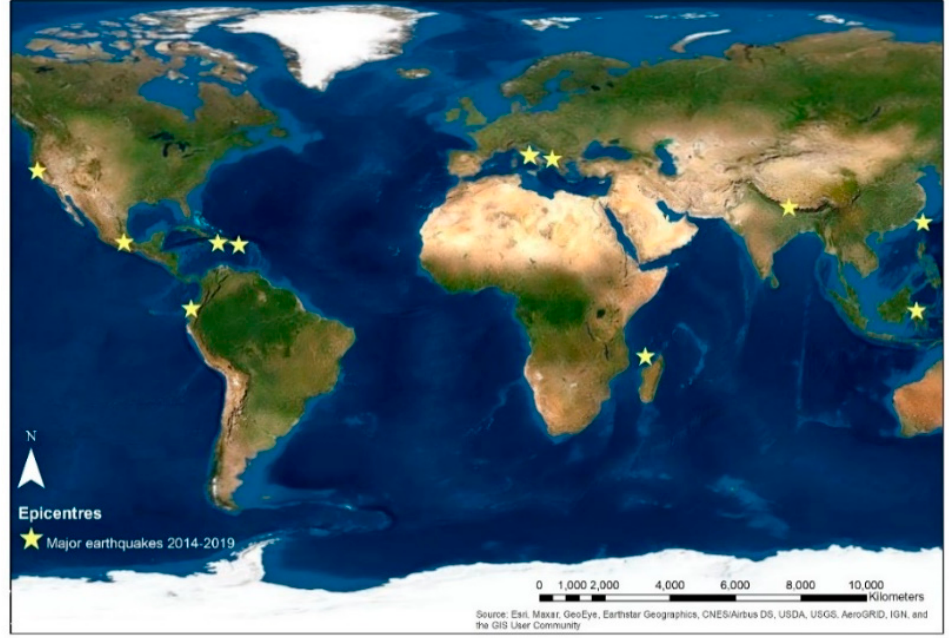
Figure 3. Spatial distribution of epicentres of major earthquakes that occurred from 2014–2019.